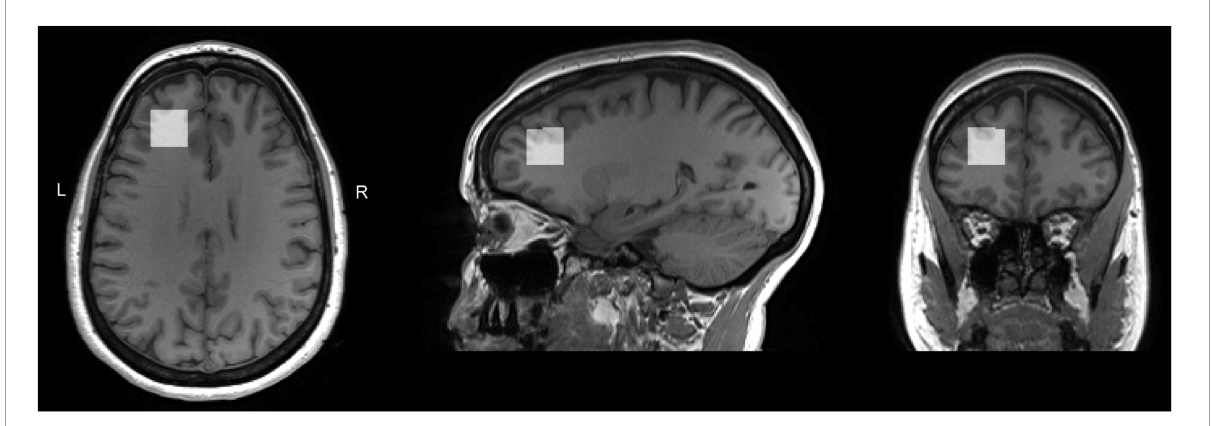
FIGURE1 T1 weighted images for a sample subject with overlaid LDLPFC MRS voxel. Voxel position and orientation were prescribed so that the voxel was perpendicular to the midline in transverse and coronal views and parallel to the corpus callosum line in a sagittal view; the voxel was then placed, using all three planes of the anatomical image, above the horn of the lateral ventricles, anterior, as far lateral as possible while remaining in the cortex. Care was taken to avoid any lipid/skull contamination.